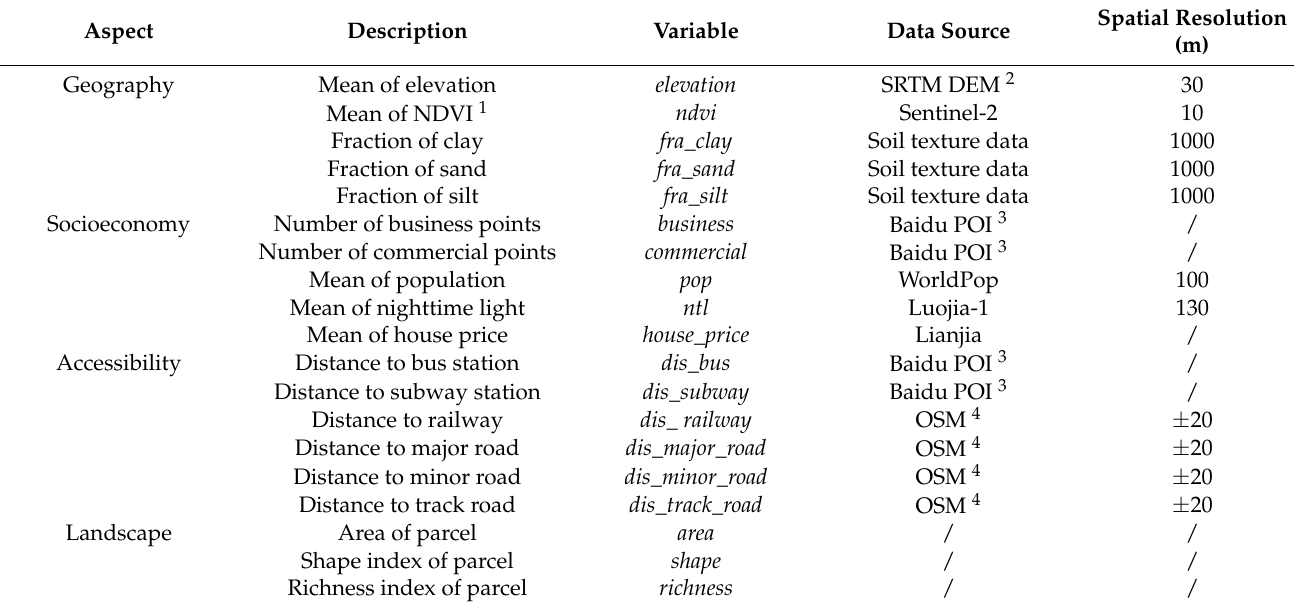
Table 2. Factors that influence land use mix. Noted all variables were calculated at the parcel scale. Aspect